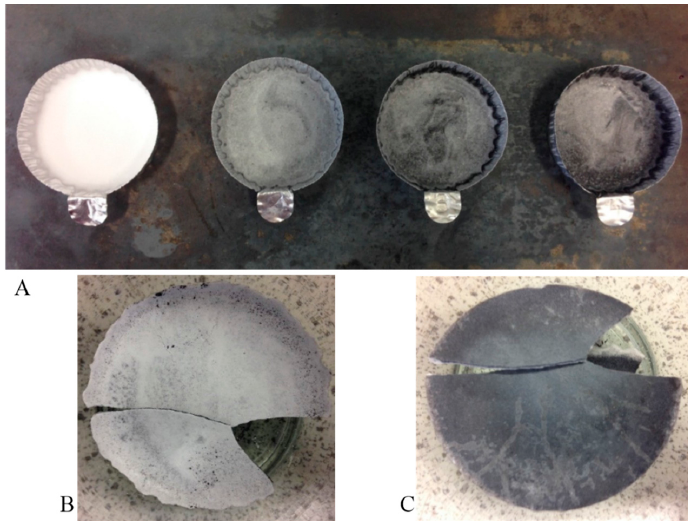
Figure 1. ( A ) Picture of the crucibles taken out of the furnace and left to crystallize on a sheet of stainless steel. The left crucible shows a sample of pure salt (white) (60/40 ratio–NaNO 3 /KNO 3 ) whilst the next three samples (left to right) contain increasing concentrations of copper oxide calculated to be 0.32, 0.98 and 1.65 wt. %; ( B ) Top view of 0.98 wt. % CuO samples; ( C ) View of the underside of 0.98 wt. % CuO solid salt mixture.